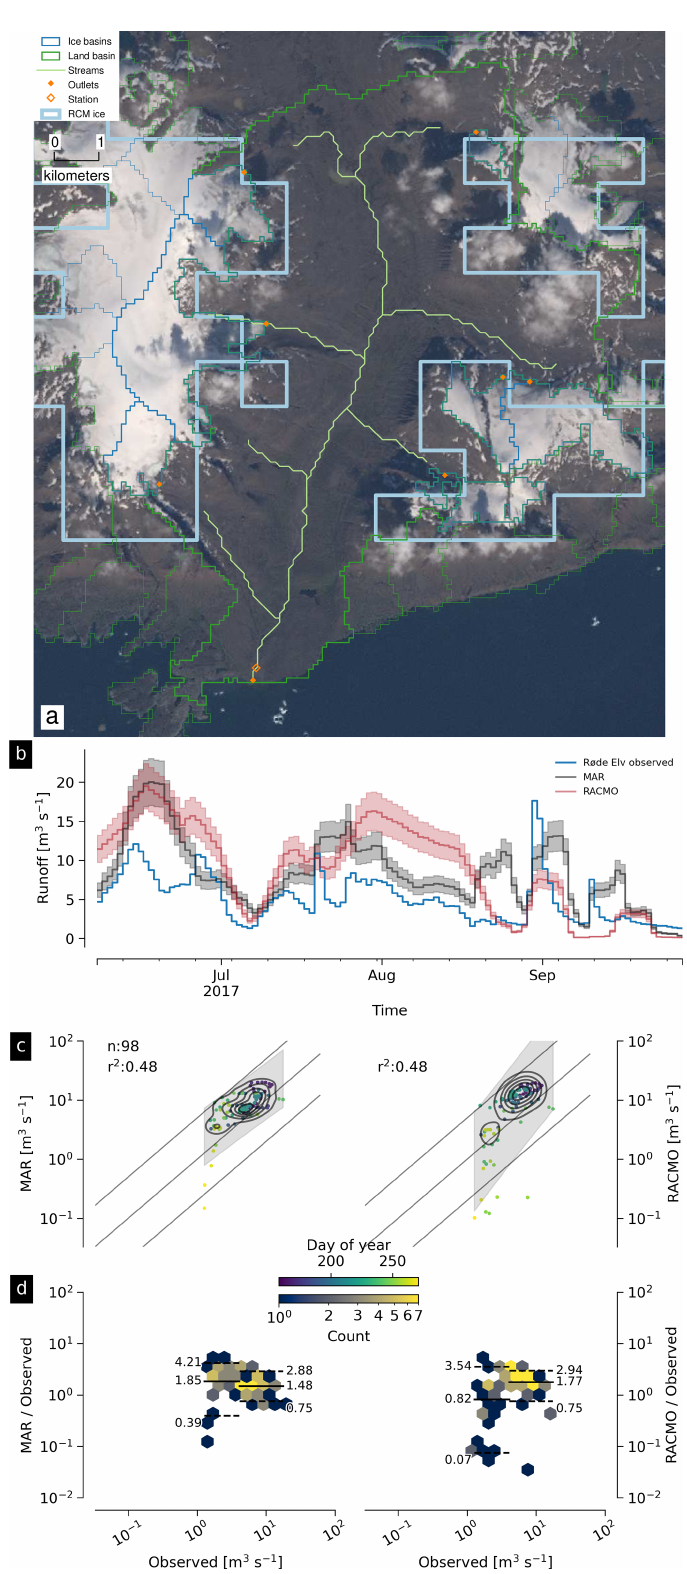
Figure 15. Graphical summary of Røde Elv outlet, basin, and discharge (R in Fig. 1). See Sect. 3.4 for a general overview of graphical elements and Sect. 4.2.6 for discussion of the Røde Elv basin. Basemap from Howat et al. (2014) and Howat